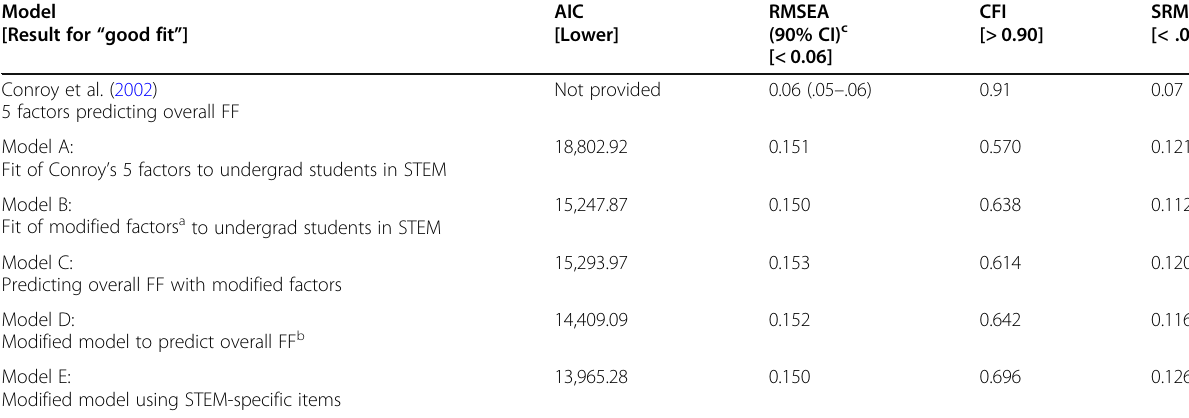
Table 4 Fit statistics for nested confirmatory factor models of the PFAI in a STEM context Model [Result for “ good fit ”